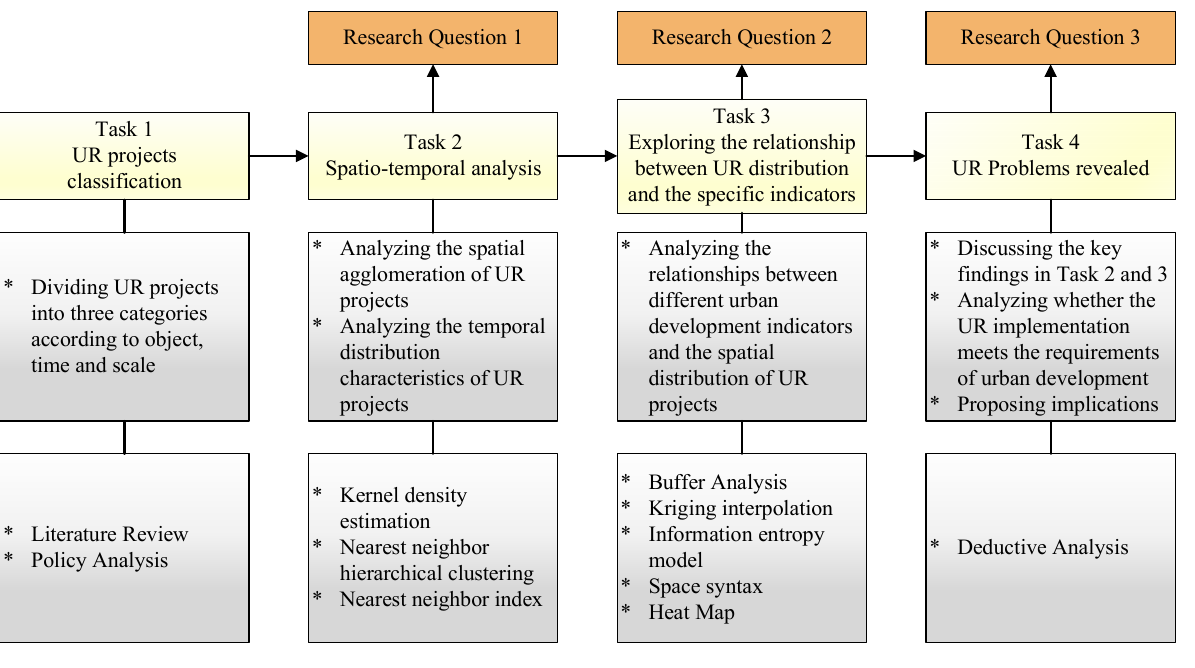
Figure 1. Research process.